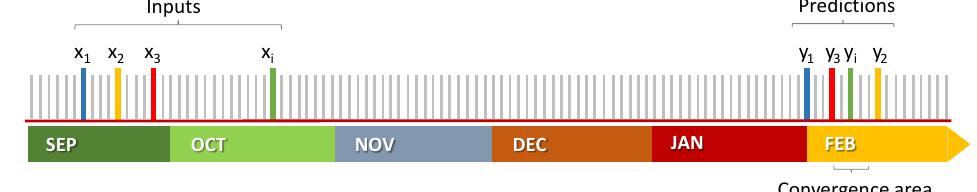
Figure 3. Timeline of the prediction